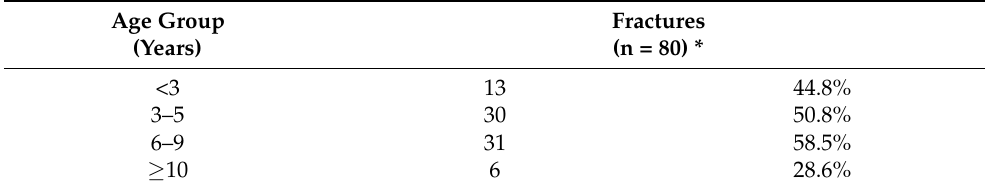
Table 3. BBR fractures in different age groups. The percentage indicates the number of fractures out of all bunk bed injuries in each age